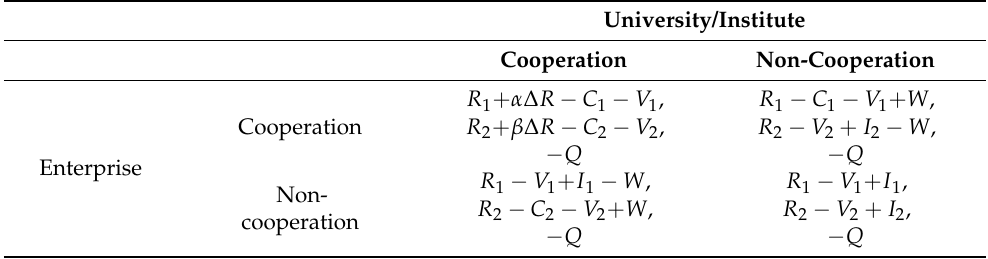
Table 2. Green technology innovation game payoff matrix of an enterprise and a university/institute without government